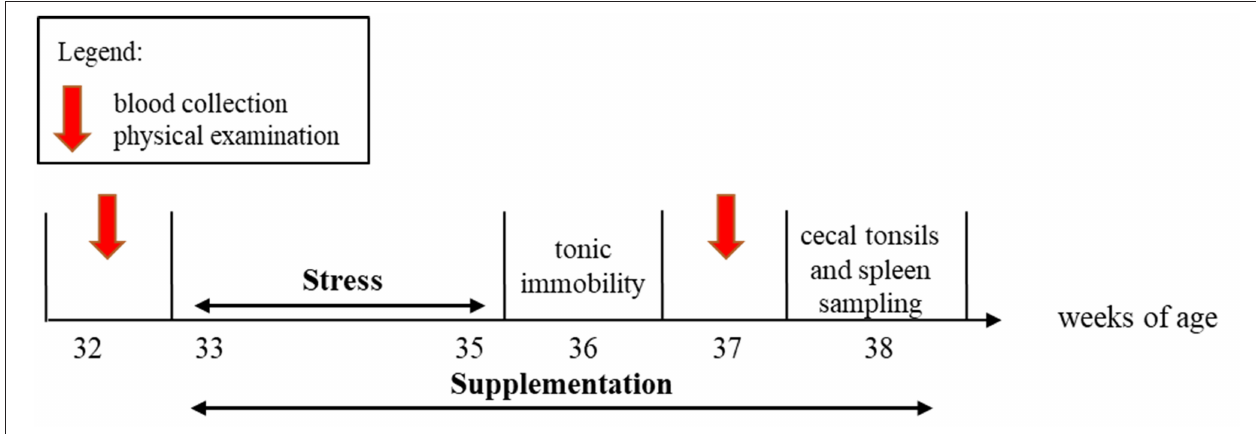
FIGURE 1 | Scheme of the experimental timeline. The L. rhamnosus or Placebo supplementation started at 33 weeks and lasted 6 weeks. The stress treatment spanned weeks 33–35. Physical examinations and blood collection were conducted at 32 and 37 weeks of age (woa). Tonic immobility was conducted at 36 woa. Spleen and cecal tonsils samplings were performed at 38